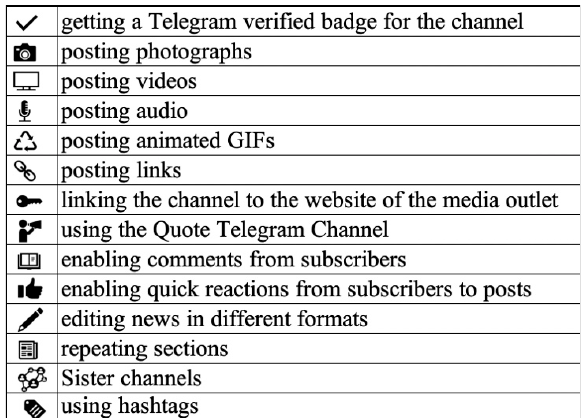
Figure 2. Features analyzed. Source: own elaboration.